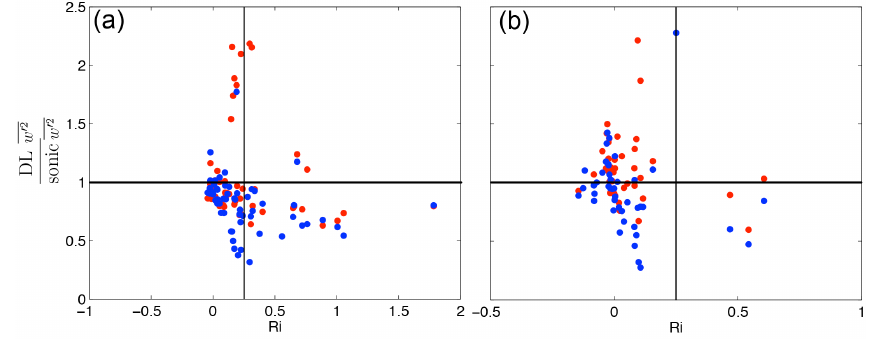
Figure 12. Relation of stability with error in lidar measured w (cid:48) 2 compared to w (cid:48) 2 computed from sonic anemometer measurements, for raw (red) and corrected (blue) measurements. Measurements from the OU DL at 300m are shown in (a) , while LLNL WC measurements at 100m are shown in (b) . For some time periods under stable conditions (e.g. Ri greater than 0.25, shown by vertical black line), uncorrected DL measurements have very high error, the ratio is greater than 2, and points are off the graph. During the study period, the conditions were predominantly near-neutral, which is why there are fewer data points during stable